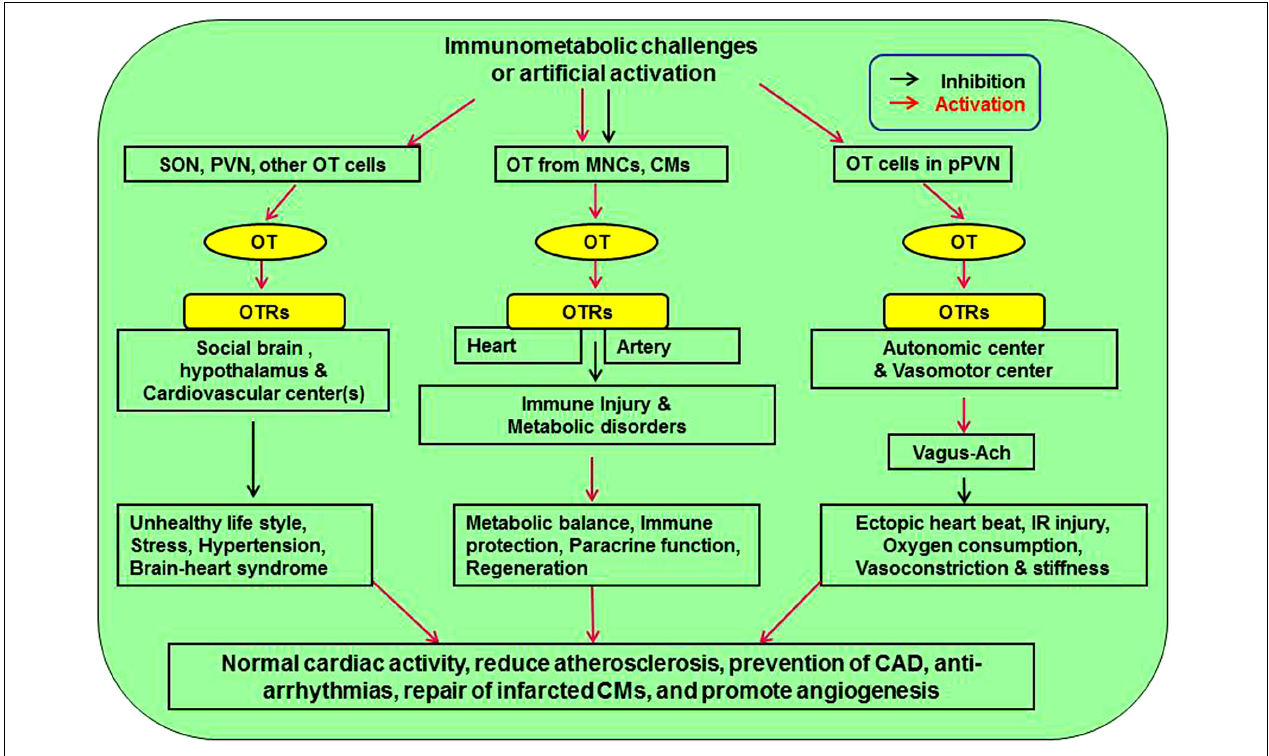
FIGURE 1 | Approaches mediating cardiovascular protective effect of OT. There are three pathways affecting cardiovascular activity. Neuronal activation of SON and PVN can counteract stress, hypertension, and brain-heart syndrome. Release of OT from MNCs and CMs inhibits atherosclerotic injuries of heart and artery by inhibiting immunological injuries and metabolic disorders through immune protection, paracrine function, and CM regeneration. Finally, activation of OT in pPVN regulates autonomic and vasomotor center activity, leading to inhibition of cardiac arrhythmia, ischemia-reperfusion injury, oxygen demand, and vasoconstriction. Ach, acetylcholine; CM, cardiomyocyte; MNCs, magnocellular neuroendocrine cells; OT, oxytocin; OTR, oxytocin receptor; pPVN, parvocellular division of the PVN; PVN, paraventricular nucleus; SON, supraoptic